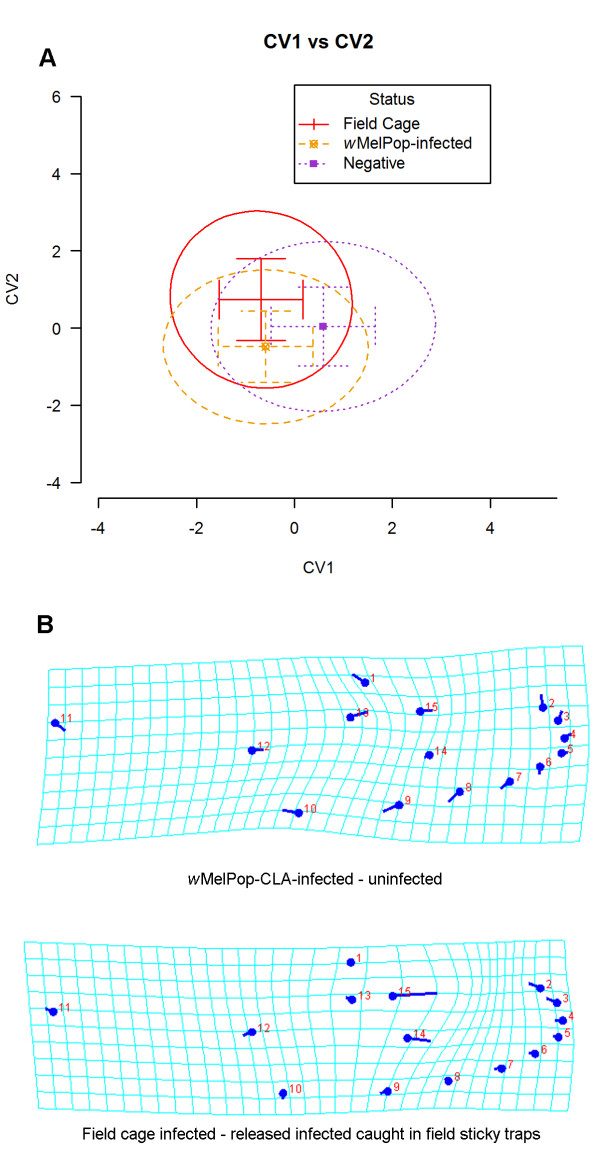
Shape differentiation between field uninfected, infected field cage and infected field released A. aegypti. Canonical variate analysis (CVA) treating infection status from DSTs and field cage as groups. (A) Canonical variate plot of mean and standard deviation, including 90% data ellipse for each group using first and second canonical variates (CV1 and CV2) that explains the greatest differentiation between groups. CV1 explains 61.9% of variation among groups while CV2 explains 29.8%. (B) Shape changes from wMelPop-CLA-infected females in DSTs to uninfected females in DSTs, and shape changes from field cage females to sticky trapped wMelPop-CLA-infected females. All shape changes were magnified 10 times for easier visualization.